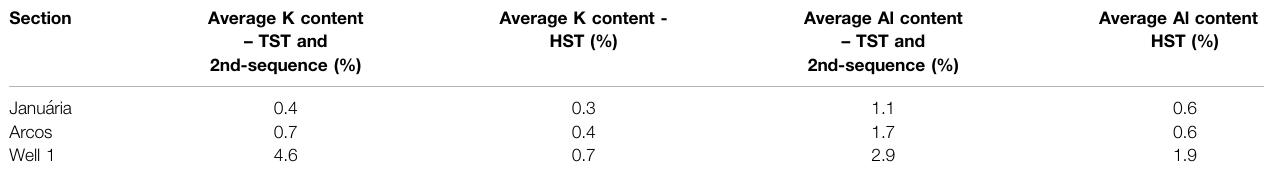
TABLE 1 | Al and K content average values during the transgressions and regressions. Section